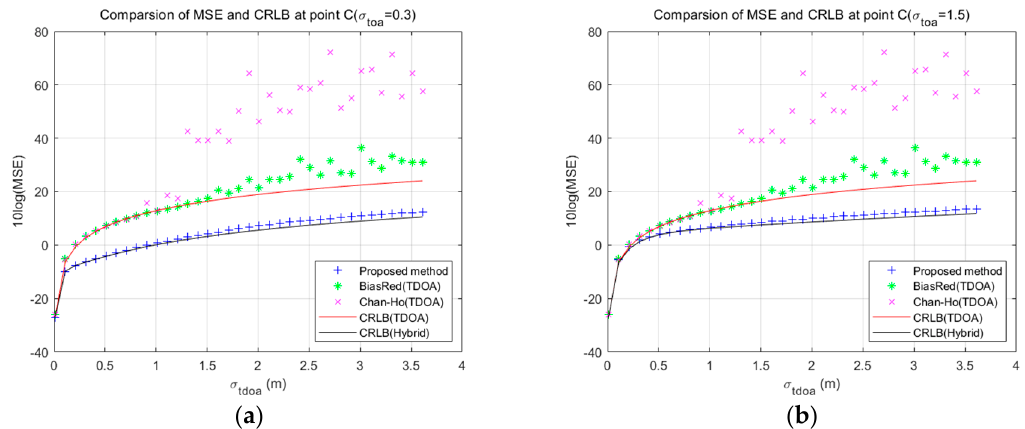
Figure 12. Accuracy of different positioning method at point C; ( a ) positioning error MSE when the standard deviation of TOA ranging error is 0.3 m; ( b ) positioning error MSE when the standard deviation of TOA ranging error is 1.5 m.